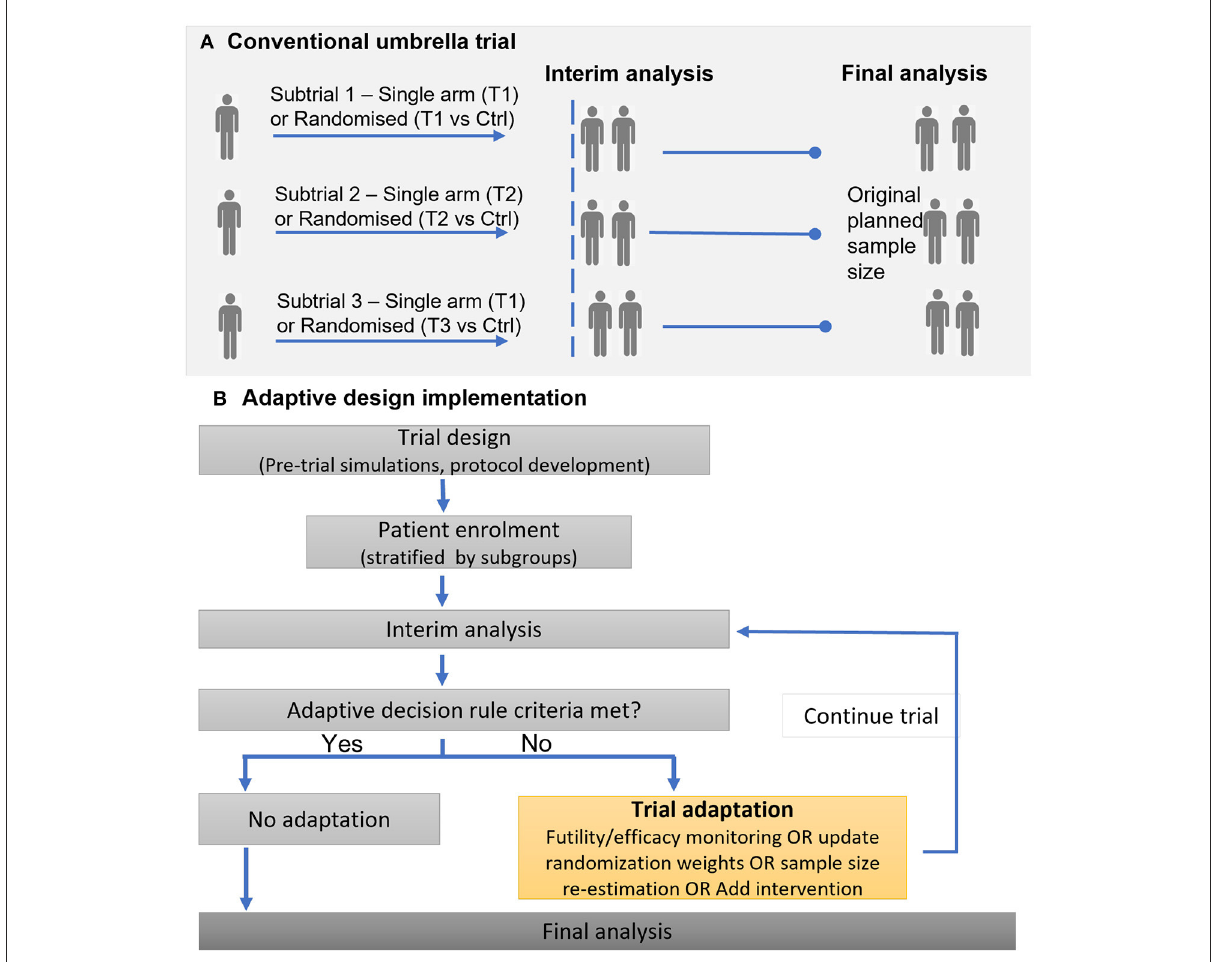
FIGURE3 Illustration of implementing a conventional (non-adaptive) umbrella trial and an adaptive umbrella trial. (A) Conventional umbrella trial. (B) Adaptive design implementation.